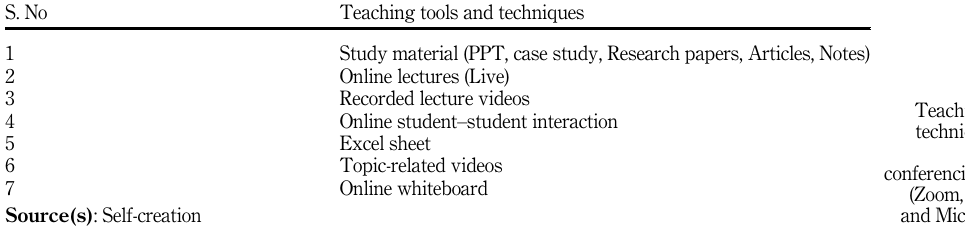
Table 1. Teaching tools and techniques used on online video conferencing platforms (Zoom, Google Meet and Microsoft